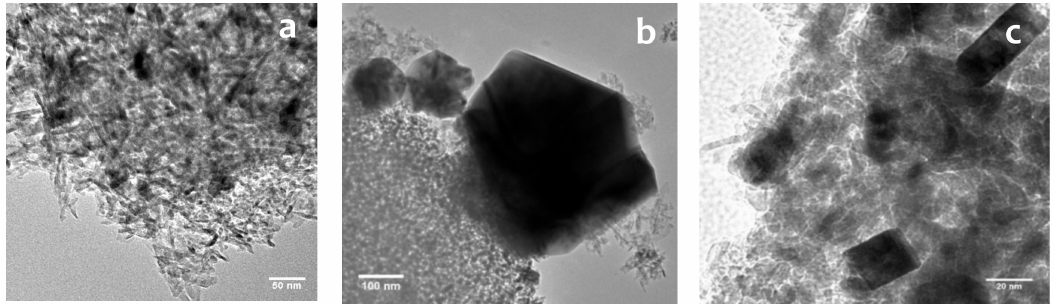
Figure 2. High-resolution TEM images of 5 wt.% Ru / Al 2 O 3 (1) ( a ), 5 wt.% Ru / Al 2 O 3 (2) ( b ) and 5 wt.% Ru / Al 2 O 3 (3) ( c ) catalysts.